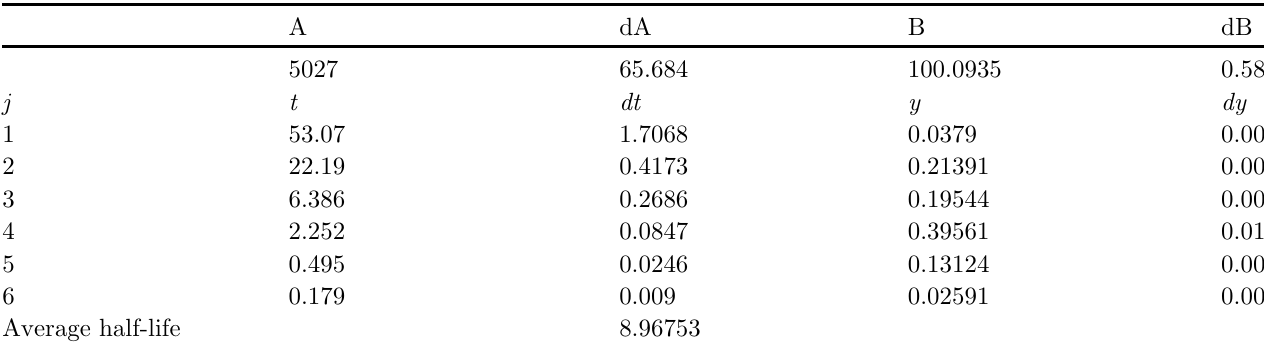
Table C5. “ Input dataset ” for testing the quality of generation of correlation matrices ( A = 5000, B = 100).